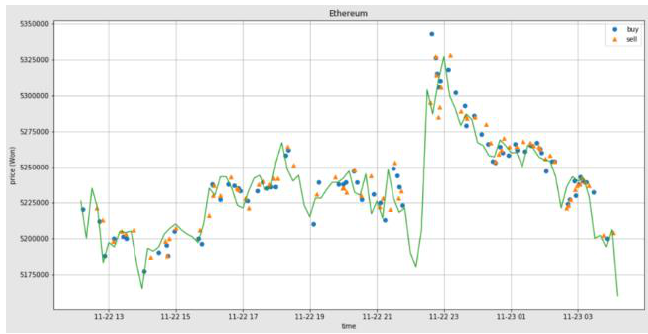
Figure 5. 80 pairs of Bitcoin trading per minute graph.